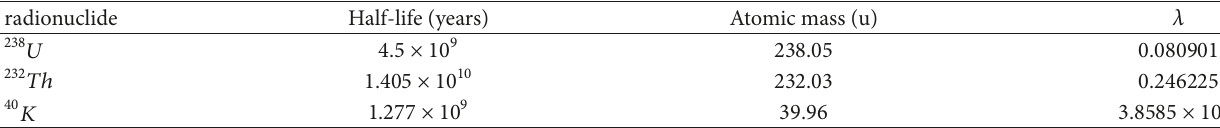
Table 4: The half-lives, atomic masses, and the calculated radioactivity conversion factors from Bq/kg to ppm for 238 U, 232 Th, 40 K